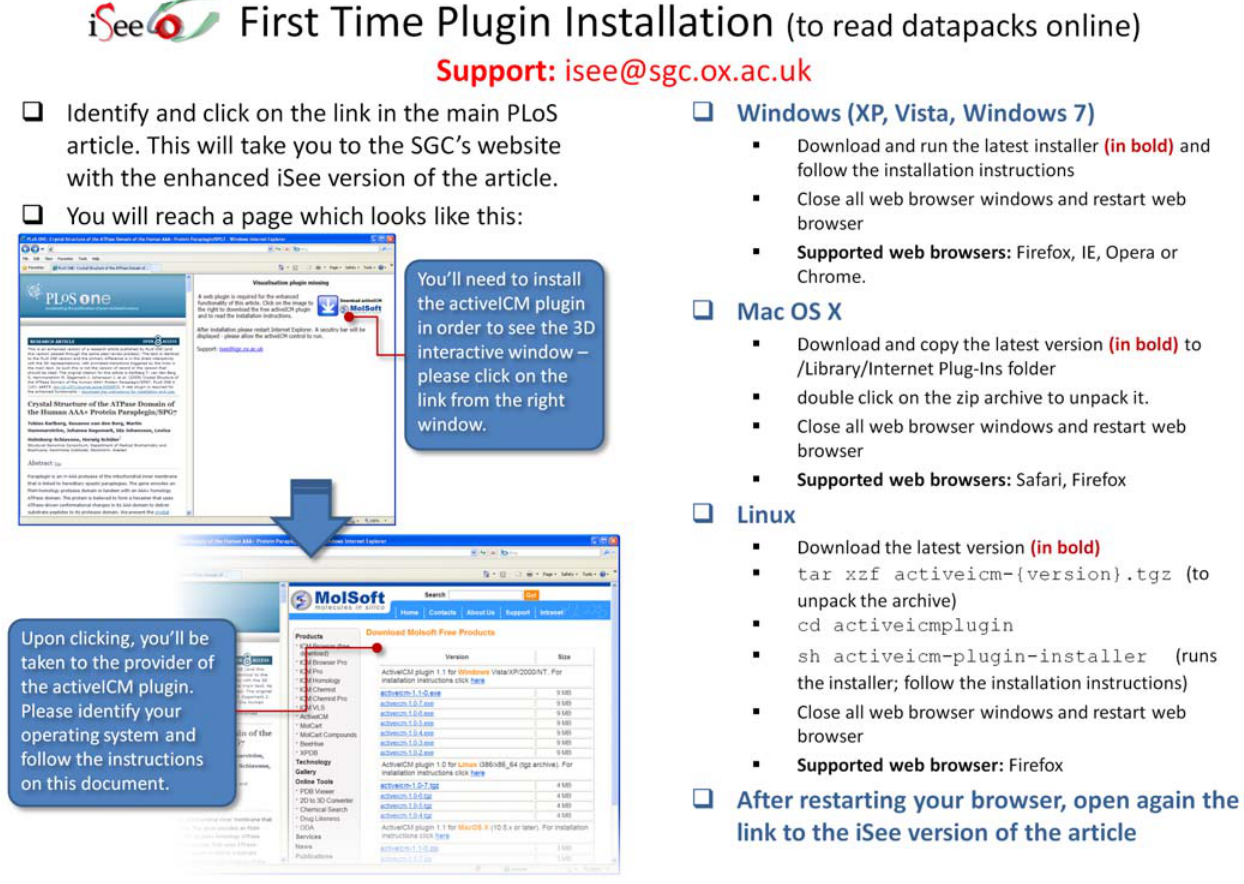
Figure 1. Reading the iSee version of the articles on-line - first-time installation instructions.